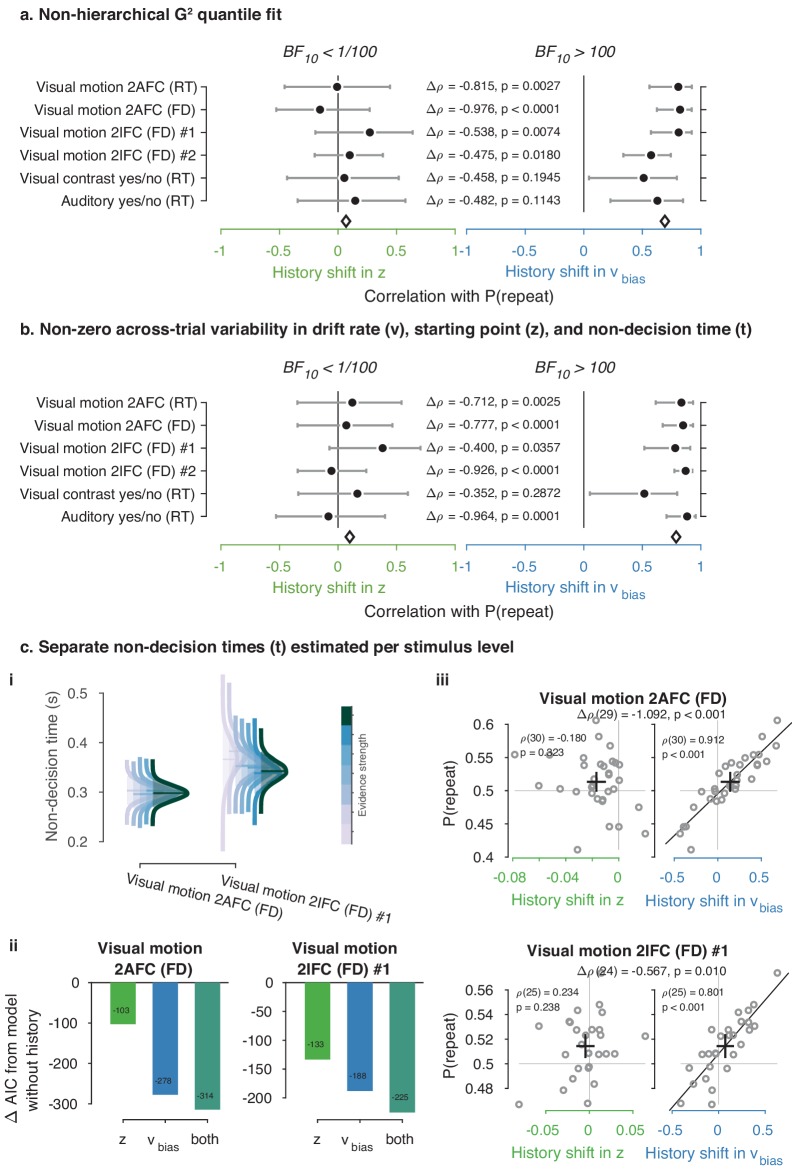
Post-error slowing.(a) We computed post-error slowing as the difference in average RT after error and correct trials. In four of the six datasets, observers showed significant post-error slowing (permutation test against zero; ***p<0.001, **p<0.01, n.s. p>0.05). We then fit an HDDM model where the overall drift rate, as well as the boundary separation, were allowed to vary depending on the outcome (correct vs. error) of the previous trial. (b) Changes in boundary separation after error vs. correct trials. (c) Changes in drift rate after error vs. correct trials. For the two datasets with multiple levels of stimulus strength, the effect of previous error vs. correct on drift rate is shown separately for each discrete level of stimulus strength (weak to strong evidence from left to right; see also Materials and methods and Figure 3—figure supplement 2a). (d–e) as (b–c), but from a HDDM model where we simultaneously allowed choice history to affect starting point and drift bias, as well as previous accuracy to affect boundary separation and drift rate. Distributions were smoothed using kernel density fits. Shaded regions represent the 95% BCI, and white lines indicate the posterior mean. Errors were succeeded by a decrease in mean drift rate in most datasets and by an increased boundary separation in some datasets: both effects conspired to slow down decisions after an error. (f) Correlations between P(repeat) and history shifts in starting point and drift bias, from the model where previous accuracy was also allowed to affect boundary separation and drift rate.